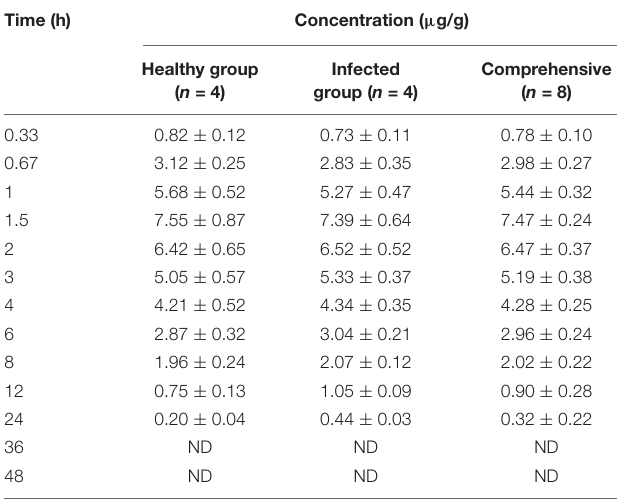
TABLE 1 | Drug concentration in lung tissues of chickens at different time points after intragastric administration of 25 mg/kg b.w.